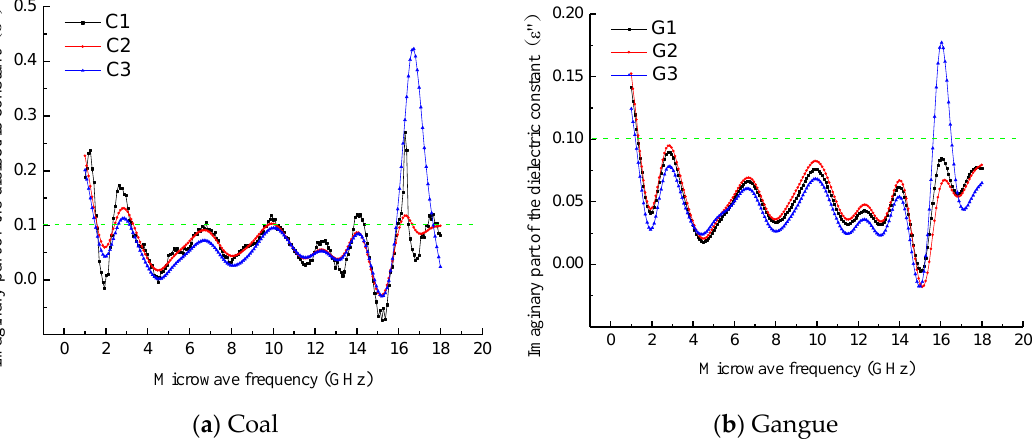
Figure 12. Change of dielectric constant imaginary part for coal and gangue samples under different particle sizes.